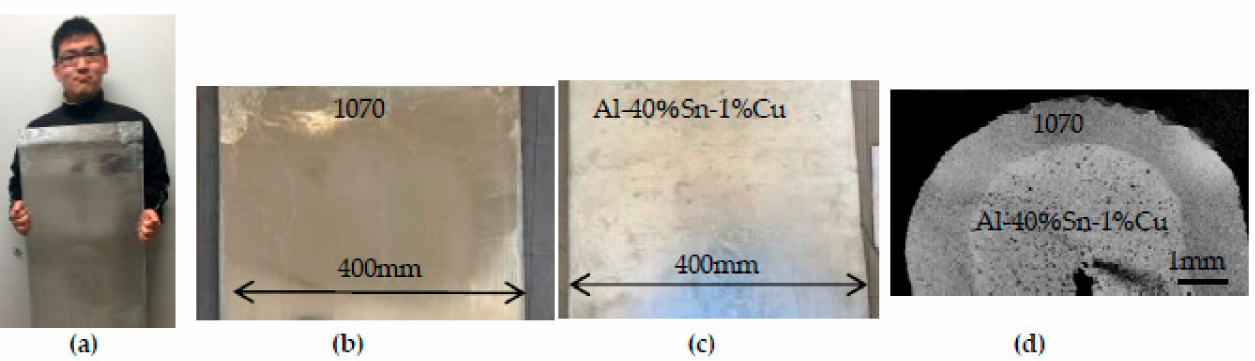
Figure 29. 400 mm clad strip consisting of a 1070 base strip and an Al-40%Sn-1%Cu overlay strip. ( a ) As-cast strip, ( b ) surface of the 1070 base strip, ( c ) surface of the Al-40%Sn-1%Cu overlay strip, ( d ) cross-section of the full-bent clad